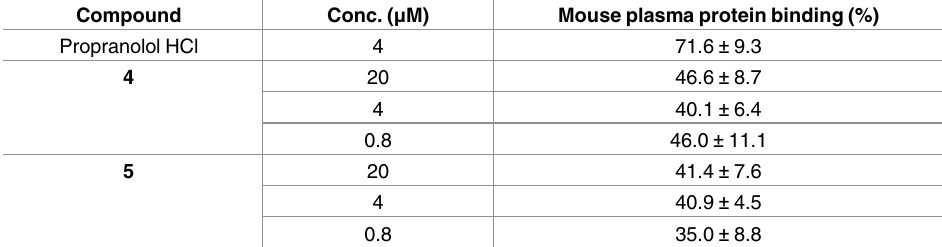
Table 2. Plasma protein binding for compounds 4, 5, and the control drug propranolol.